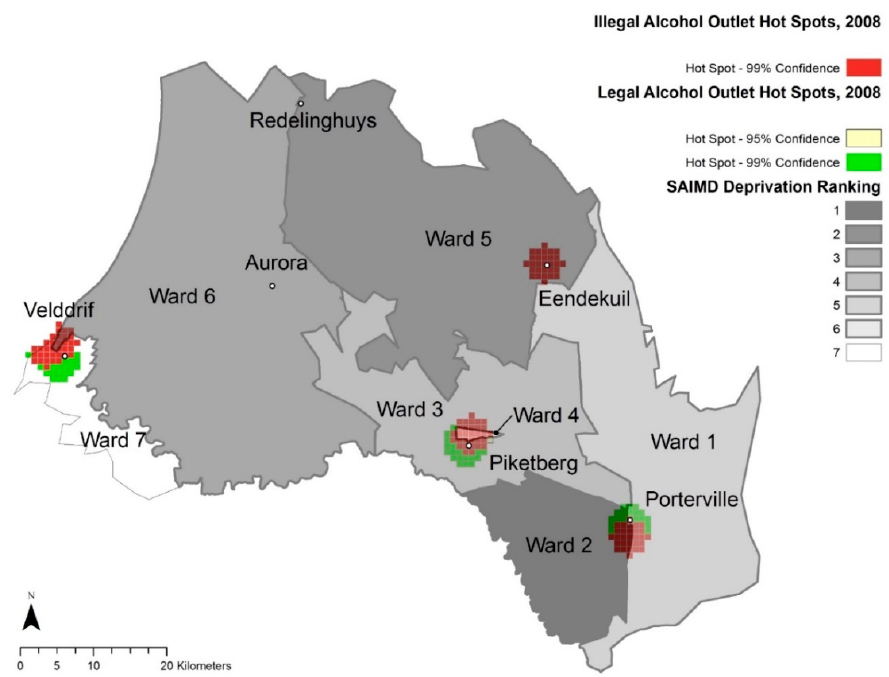
Figure 5. Illegal and Legal Alcohol Outlet Hot Spots, 2008 and Ward Deprivation.